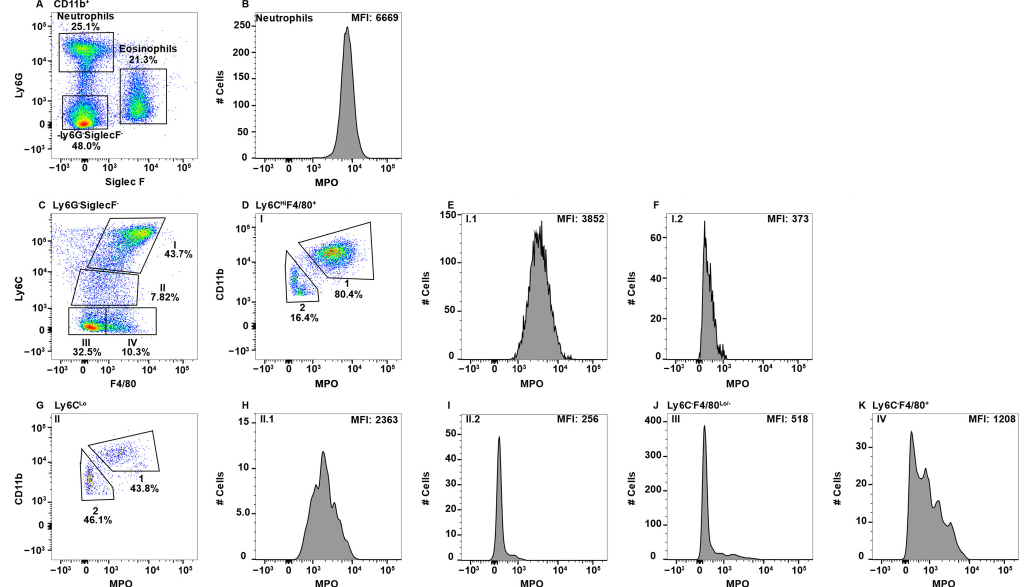
Figure 2. Blood monocyte/macrophage subsets differentially express MPO. PBMC were stained with antibodies specific for CD45, CD11b, Ly6C, Ly6G, F4/80, MPO, and SiglecF and using flow cytometry, CD45 + cells were gated on CD11b. Neutrophils and eosinophils were identified by expression of Ly6G and SiglecF, respectively ( A ). Neutrophil MPO positive staining is shown ( B ). CD11b + Ly6G − SiglecF − cells were analyzed for F4/80 and Ly6C expression and four Subpop (I–IV) were identified ( C ). Subpop I F4/80 + Ly6C Hi cells were separated into CD11b Hi (1) and CD11b Lo (2) populations ( D ), and MPO expression is shown ( E and F , respectively). Subpop II Ly6C Lo cells were separated into CD11b Hi (1) and CD11b Lo (2) populations ( G ), and MPO expression is shown ( H and I , respectively). MPO expression in Subpop III F4/80 − Ly6C − cells ( J ) and Subpop IV F4/80 + Ly6C − cells ( K ) is shown. The percent positive cells in dot plot gates and the MFI of histograms is provided. Data shown are representative of three mice.